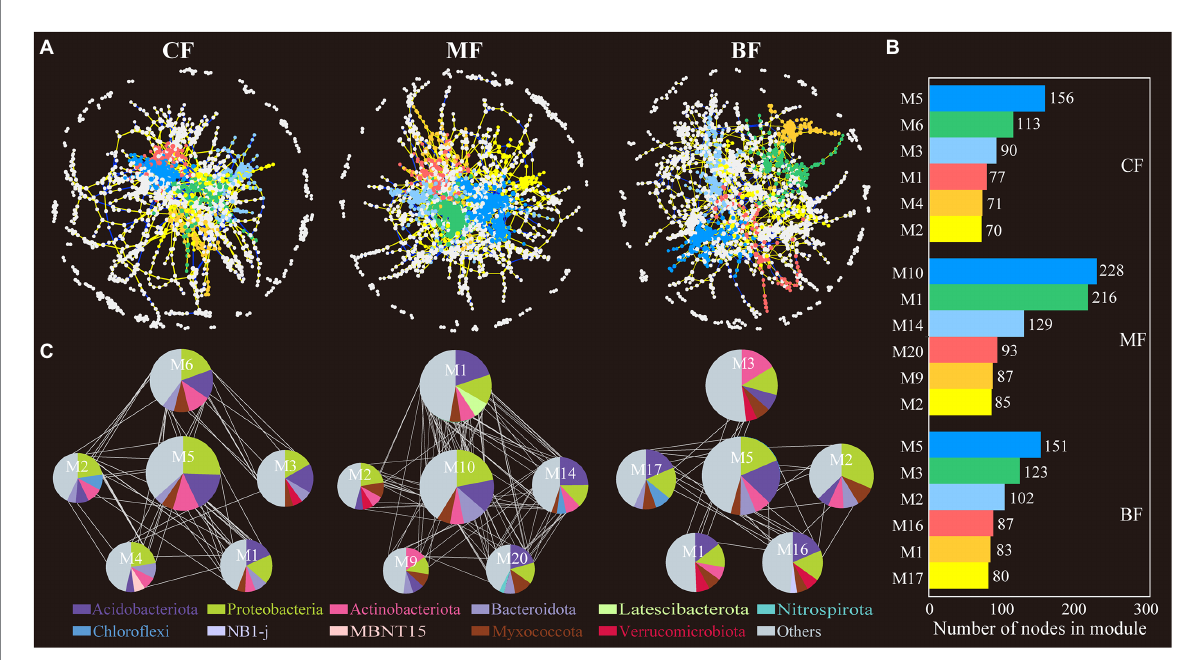
FIGURE 6 Bacterial co-occurrence network (A) and the module analysis (B,C) based on correlation analysis under forest stand differences. The size of each node represents the degree. The yellow lines indicate positive interactions, blue lines indicate negative interactions, while the gray lines indicate correlations between each